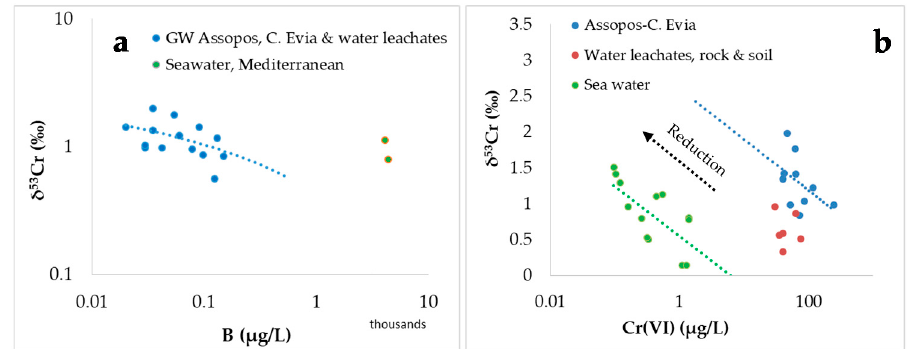
Figure 5. Plot of the δ 53 Cr values versus B ( a ), and Cr(VI) ( b ) concentrations for coastal groundwater (GW) from the C. Evia, Assopos–Thiva Basins, water leachates for rocks (serpentinized peridotites) and soils, and seawater (Mediterranean Sea, Pacific and Atlantic oceans, and Baltic Sea). Data from refs [38,46,47,50].